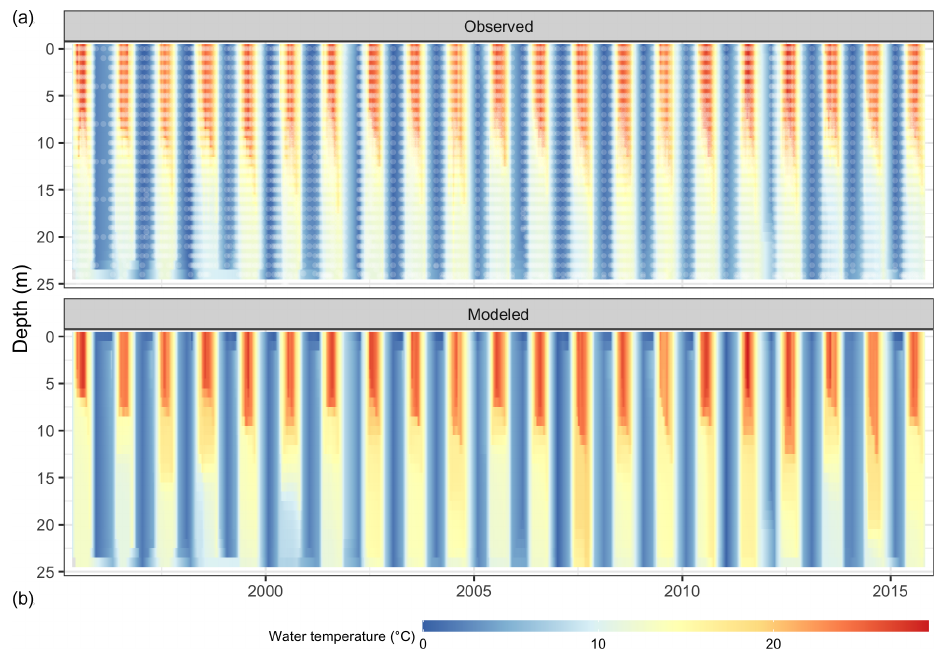
Figure 4. Comparison of Lake Mendota water temperature from observations ( a , white dots mark sampling events) and GLM-AED2 simu- lations (b) .